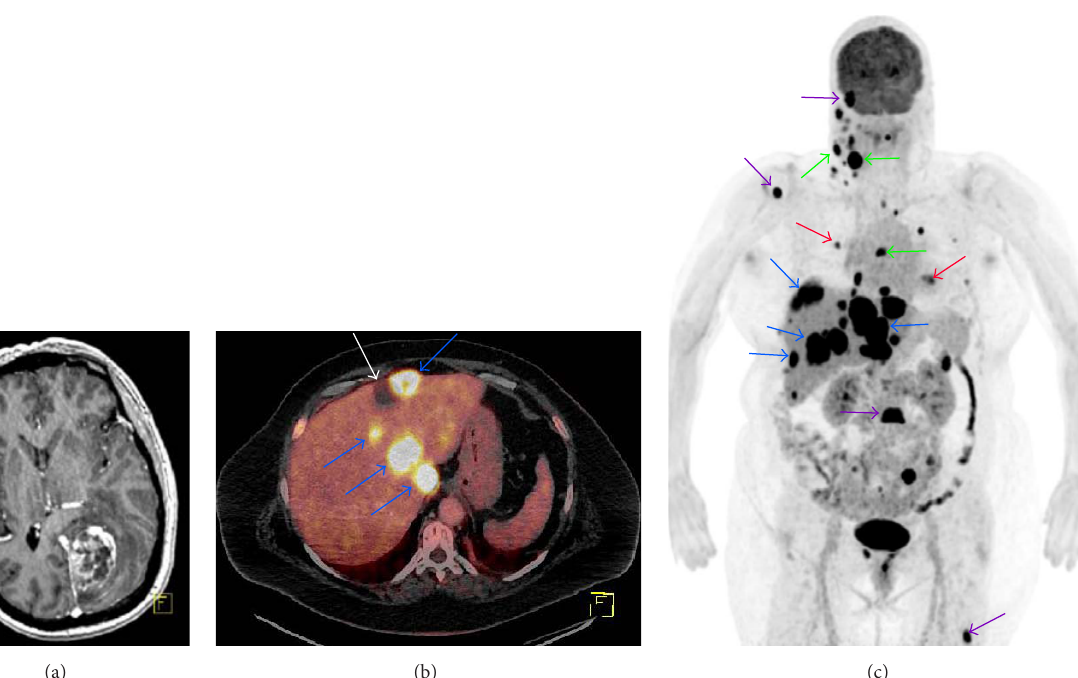
Figure 1: Case 1. (a) Preoperative post-contrast enhanced T1 weighted MRI showing the localization of the tumor in close proximity to the falx. (b) Fused FDG PET/CT scanning at liver level 5 months after diagnosis of GBM showing multiple metabolically active metastases (blue) and inactive liver cyst (white). (c) Frontal maximum intensity projection (MIP) image of whole body FDG PET scanning identifying disseminated metastatic spread to lymph nodes (green), lungs (red), bone (purple), and liver (blue). Physiological excretion to intestines, kidneys, and the